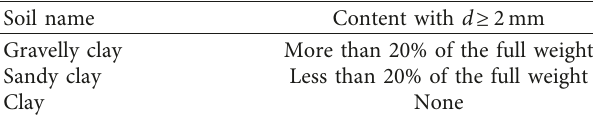
Table 2: Classification of granite residual soil in